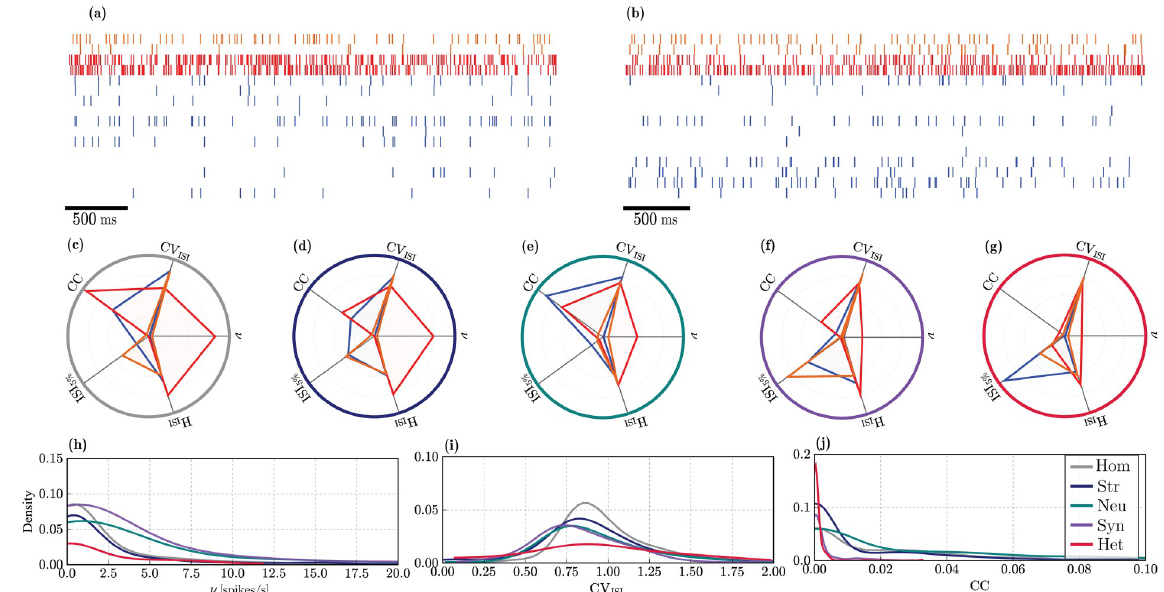
Fig 6. Statistical properties of spiking activity in the active state for the E (blue), I 1 (red) and I 2 (orange) populations. ( a, b ): Example raster plots depicting the activity of a small, randomly chosen subset of neurons, over a recording period of 2.5s in a homogeneous and fully heterogeneous circuit, respectively. ( c )-( g ): Activity statistics profiles for the different populations (overlaid) in the different conditions. The radial axes represent: mean pairwise correlation coefficient (CC), coefficient of variation of the inter-spike intervals (CV ISI ), mean firing rate ( ν [spikes/s]), entropy (H ISI [bits]) and burstiness (ISI 5% [s]) of the firing patterns. The values along the radial axes are normalized to the largest value across all neuron classes in each condition. The units have been removed for better legibility (see S3 Fig). ( h )-( j ):Distribution of firing rates ν [spikes/s], CV ISI and CC for the E population in the different heterogeneity conditions (see legend in ( j )). The results depicted are population averages, obtained from one simulation per condition.